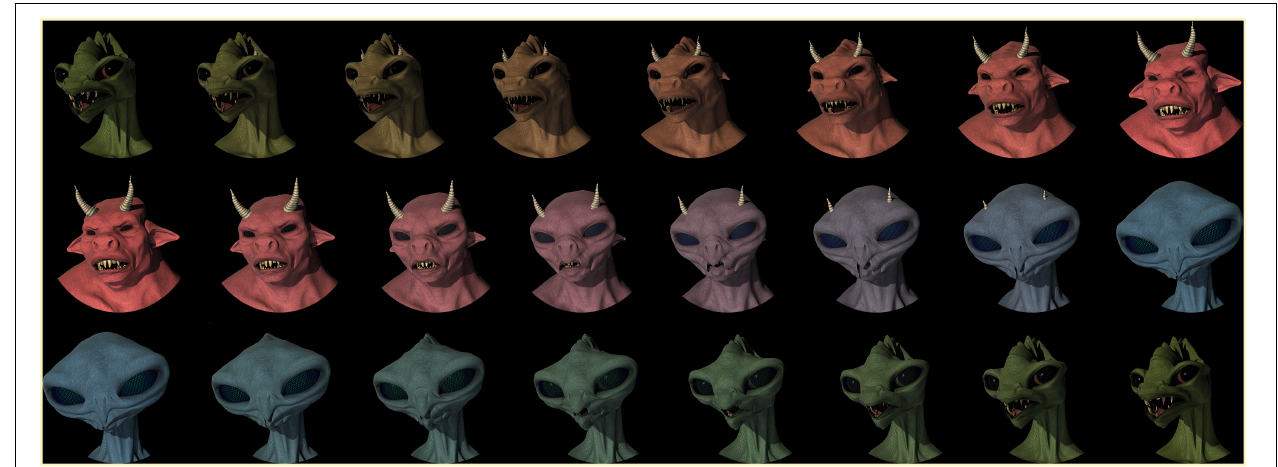
FIGURE 3 | Reptile-beast, beast-alien, and alien-reptile morph continua; stimuli shown here: 1, 3, 5, 7, 9, 11, 13, and